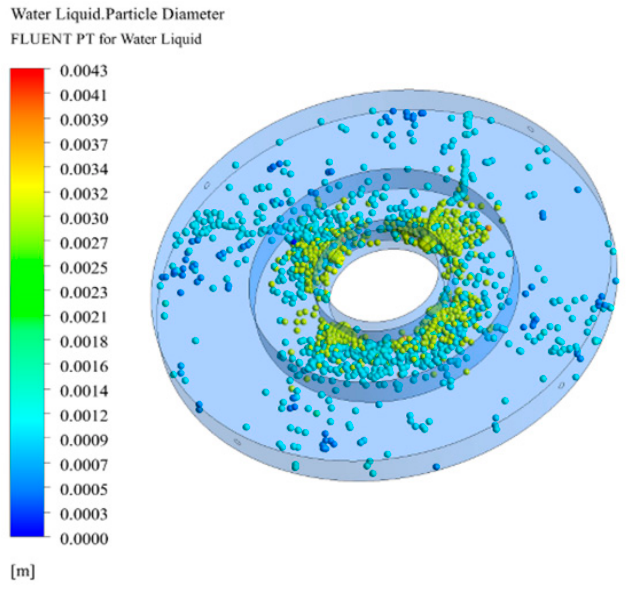
Figure 12. A 3D droplet diameter distribution in RPB.